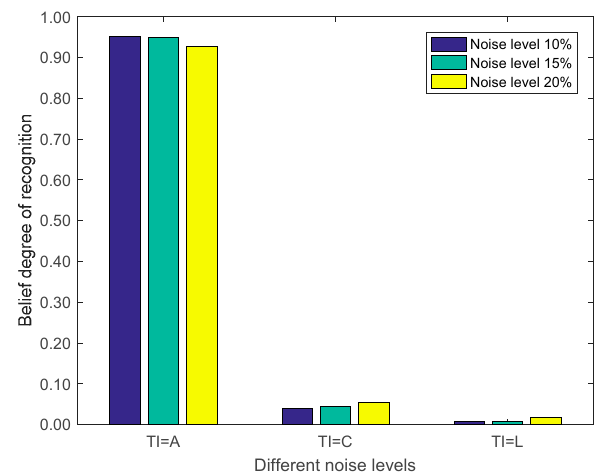
Figure 8. Target intention recognition belief under different noise levels.